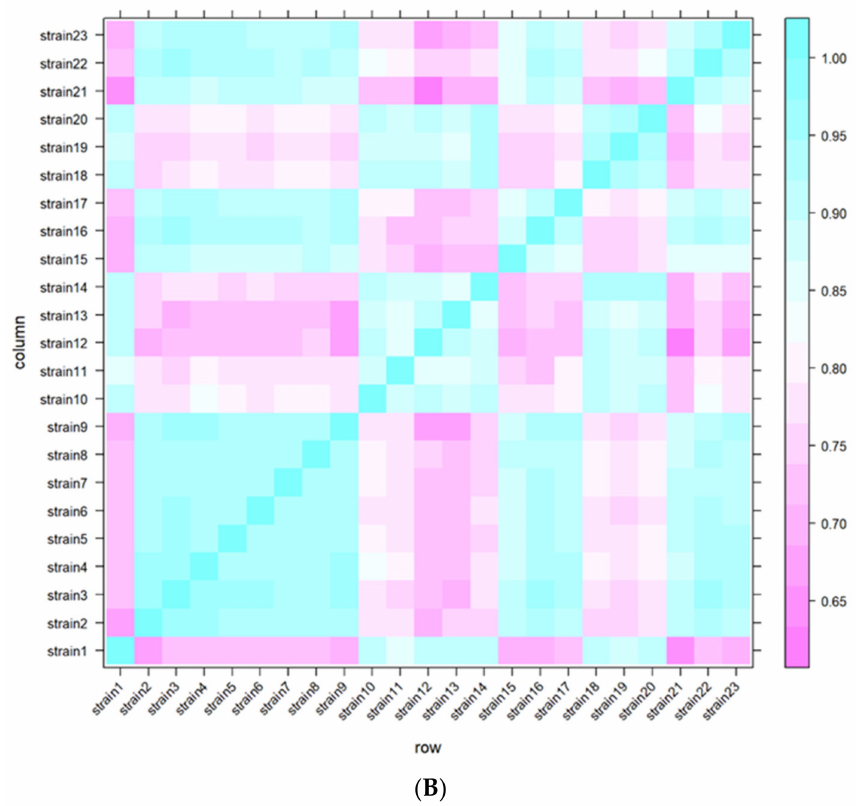
Figure 3. Different plots representing the differentiation and/or similarity between the S. aureus isolates collected and sequenced in this study, including the original strains ( S. aureus ATCC 29213 and S. aureus Z25.2). ( A )—multidimensional scaling (MDS) plot of the S. aureus isolates sequenced, including of the original strains; ( B )—heatmap representing the similarity of the different isolates. The intensity of the blue color represents the level of similarity between isolates, while the intensity of the pink color represents the level of dissimilarities between